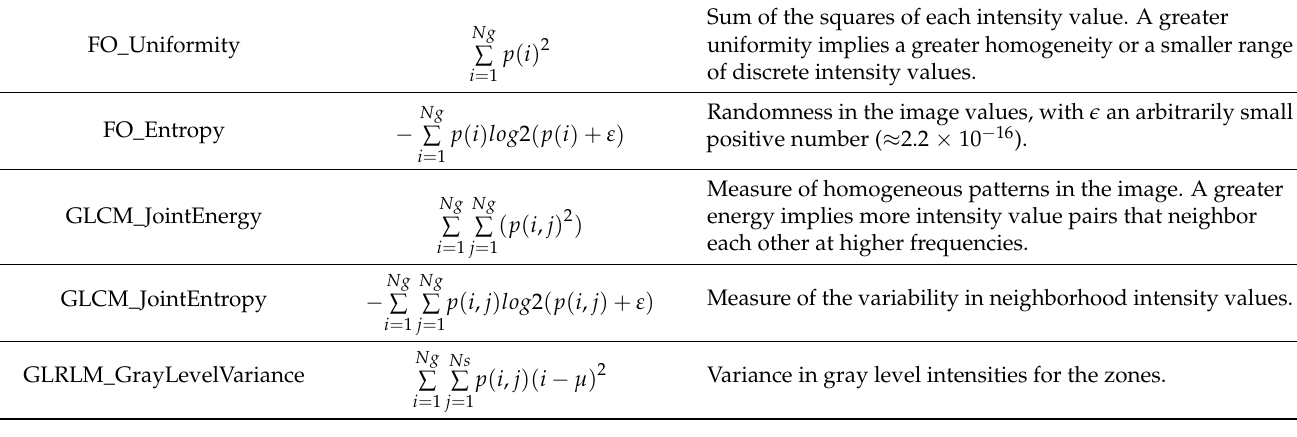
Table 2. Signification of the radiomics features significantly associated with the outcome in the training cohort.